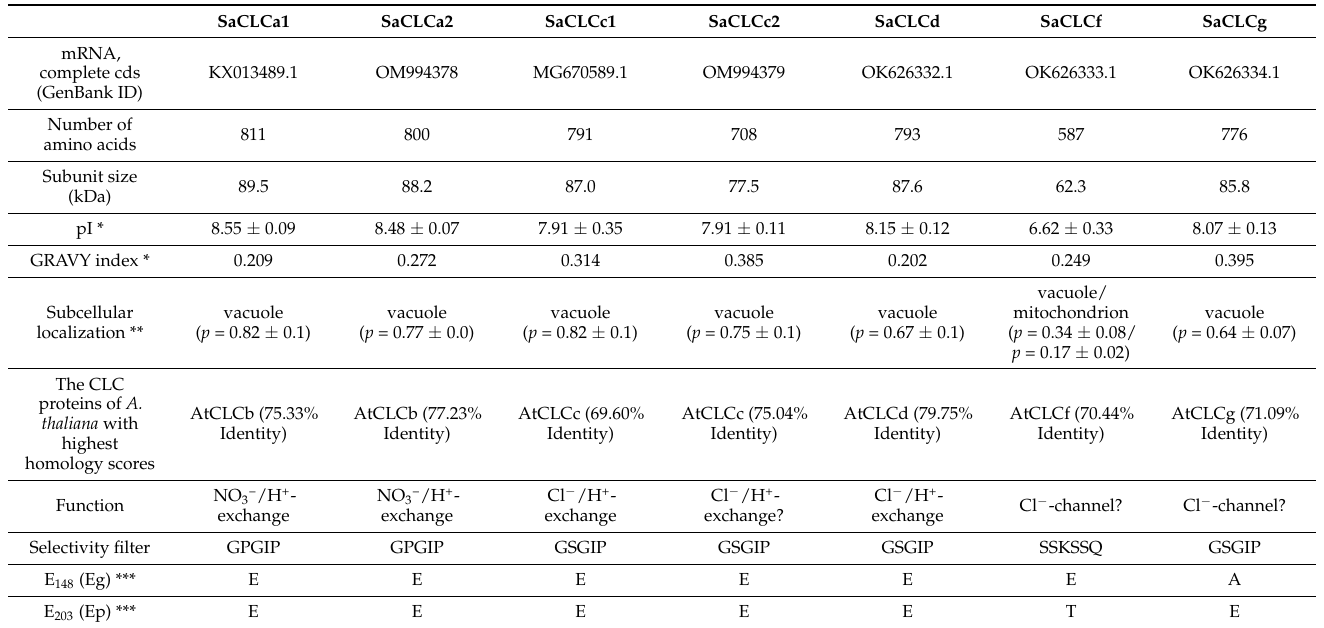
Table 1. Features of chloride channel family proteins from the euhalophyte Suaeda altissima (calculated